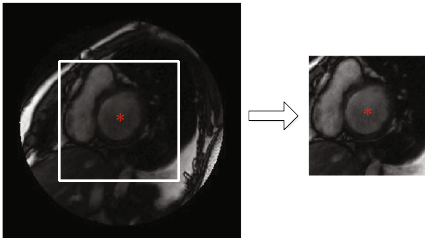
Figure 2: ROI cropping. The image on the left is the original slice, and the white box represents the ROI containing the LV. The image on the right is the corresponding cropped